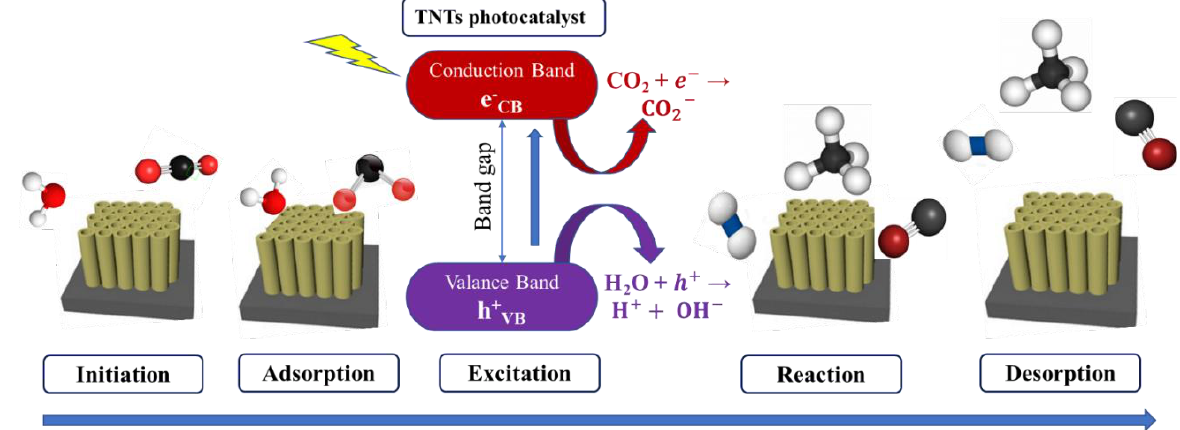
Figure 11. Possible steps occurring in photoreactor for CO 2 photoreduction.